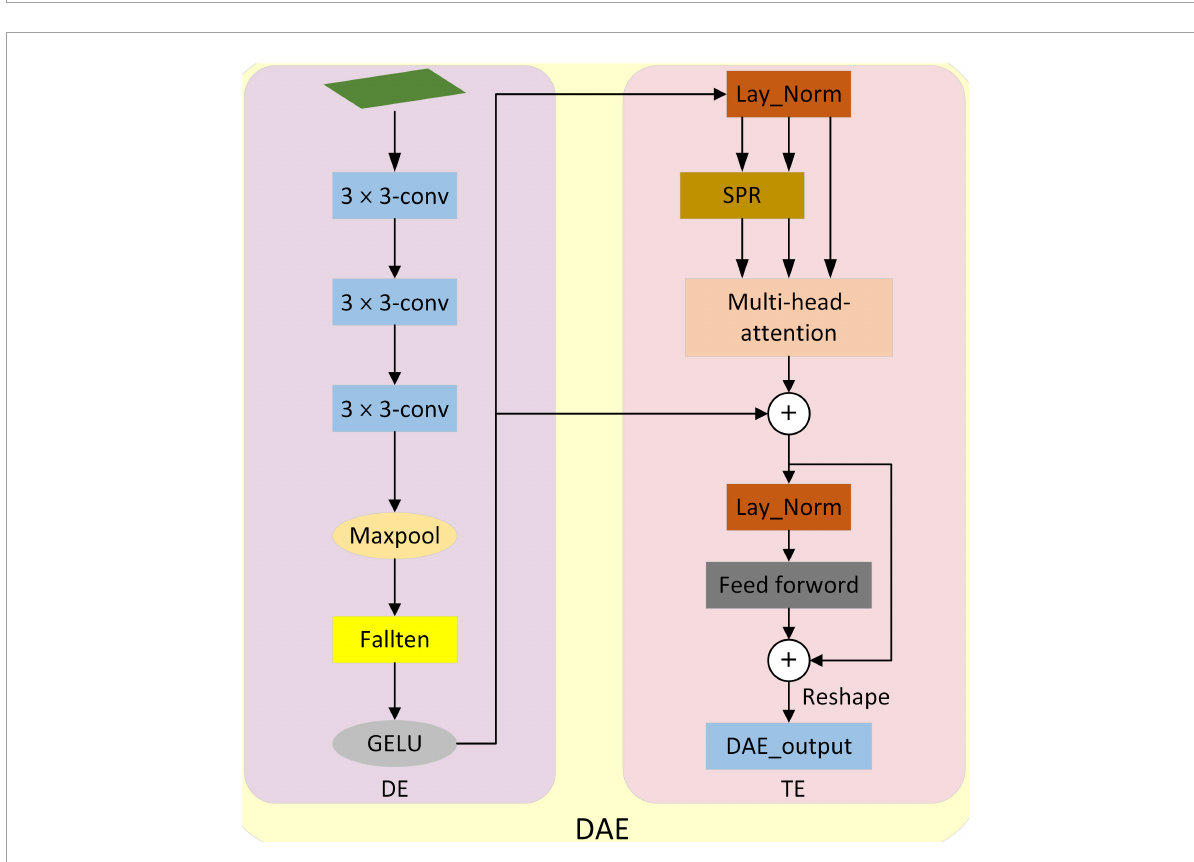
FIGURE4 Structure Diagram of down-sampling attentional enhancement module. It consists of down-sampling embedding (DE) and transformer_encoder (TE). DE implements down-sampling processing and patch embedding operation of the input image. The TE implements selective feature extraction and outputs the results at